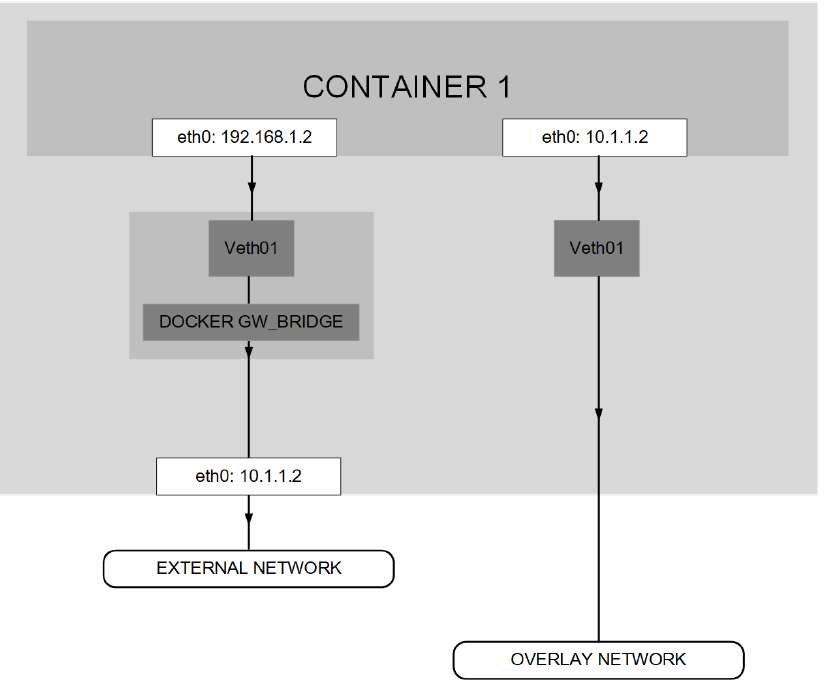
Figure 9. Docker overlay